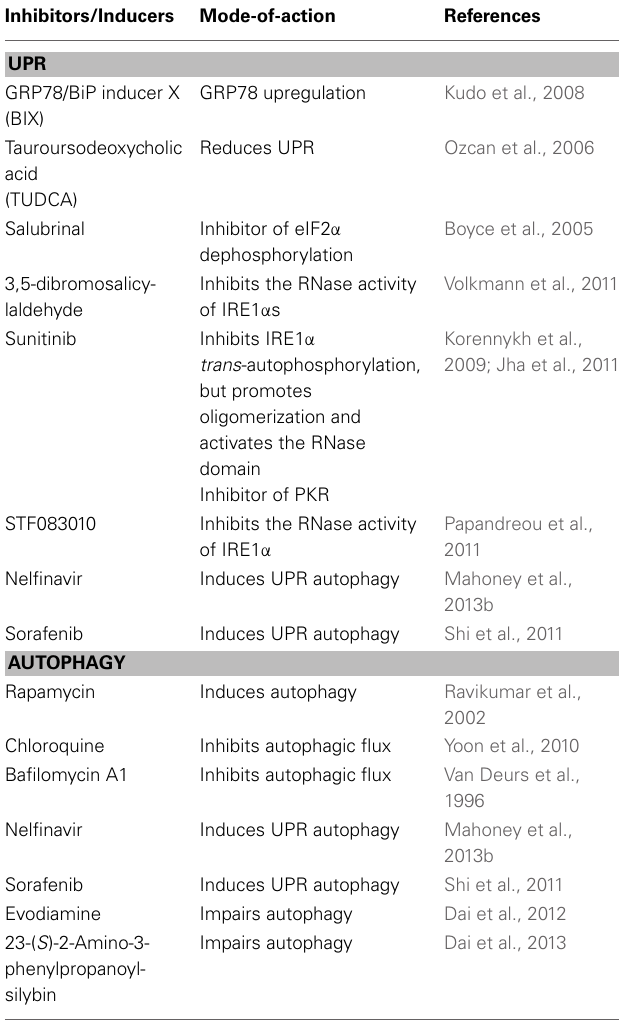
Table 2 | Compounds affecting UPR and